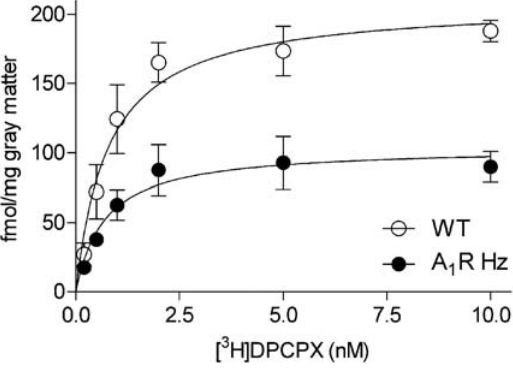
Figure 4. [ 3 H]DPCPX-binding in the Nucleus accumbens. Saturation curve of [ 3 H]DPCPX-binding in the Nucleus accumbens from WT and A 1 R Hz mice. Significant difference in B max values for the two groups was found by Student’s t test (B max WT 208 6 8.23 fmol/gray matter, n=6, A 1 R Hz 104 6 5.36 fmol/gray matter, n=6, df=10, ***p , 0.001). The same was observed in